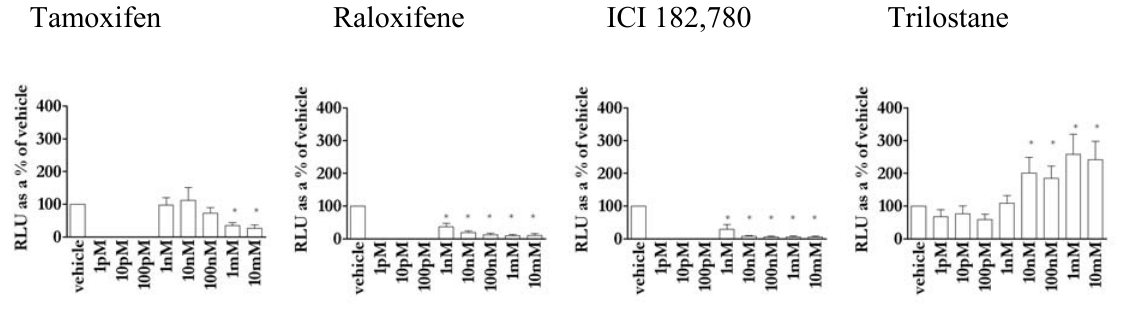
Figure 3. Antioestrogen (3A: tamoxifen, 3B: raloxifene, 3C: ICI 182,780 and 3D: trilostane) repression of basal reporter activity compared to basal activity in MCF-7 cells. * = significant stimulation/repression (P < 0.05) above/below